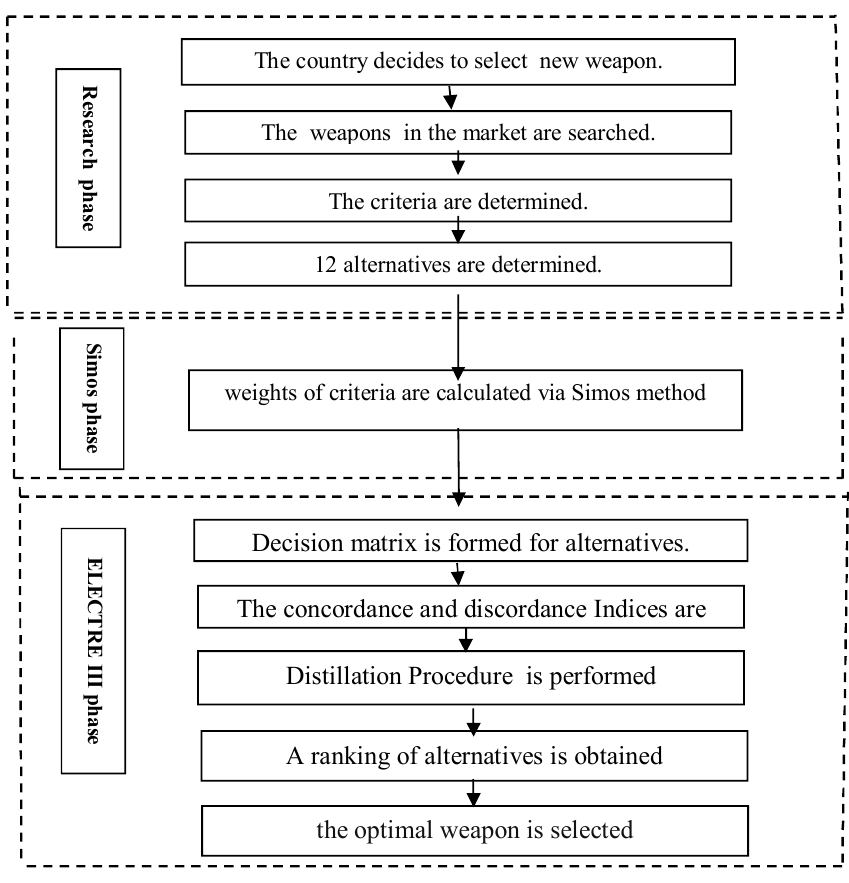
Fig. 2. Schematic diagram of the proposed